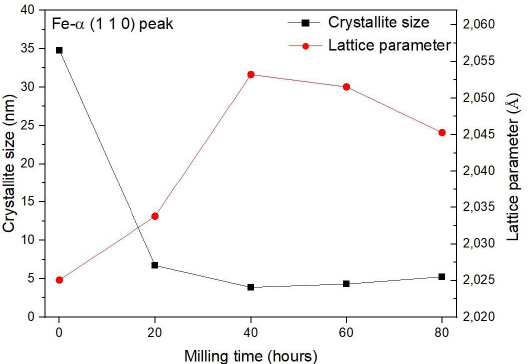
Figure 18. Crystallite size and lattice parameter as a function of different milling times for the (110) Fe-α peak for Fe-15at.%Nb samples with stearic acid